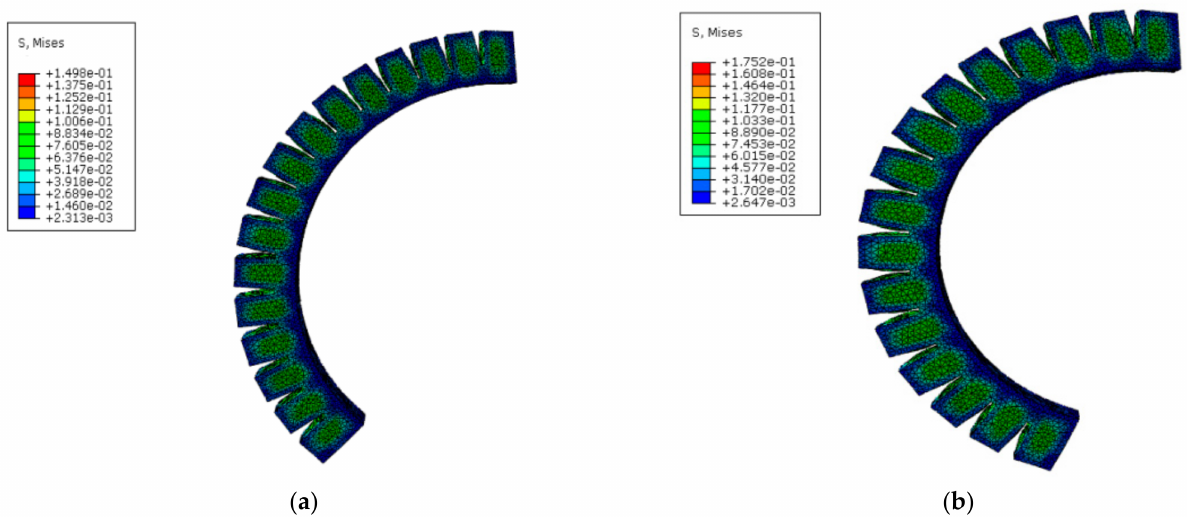
Figure 5. Simulation of soft manipulator: ( a ) simulation result without the Mullins effect; ( b ) simulation result with the Mullins